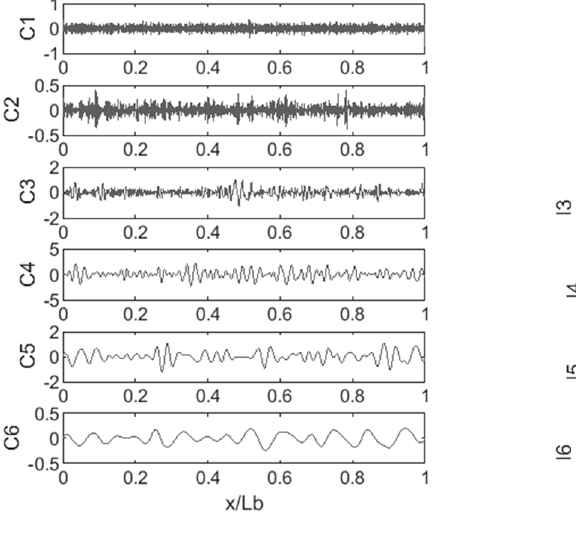
Table 2. Comparison of the frequency estimated by EMD and EEMD for different vehicle velocities. Speed = 5 m/s